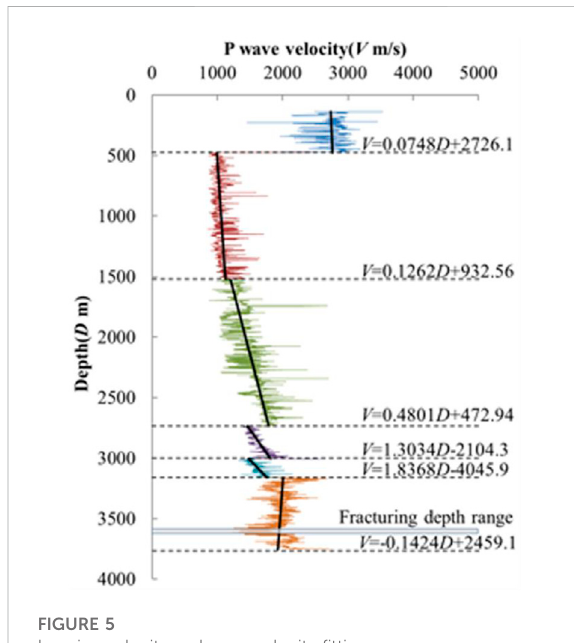
FIGURE 5 Logging velocity and wave velocity fi